Question: What type of chart is this?
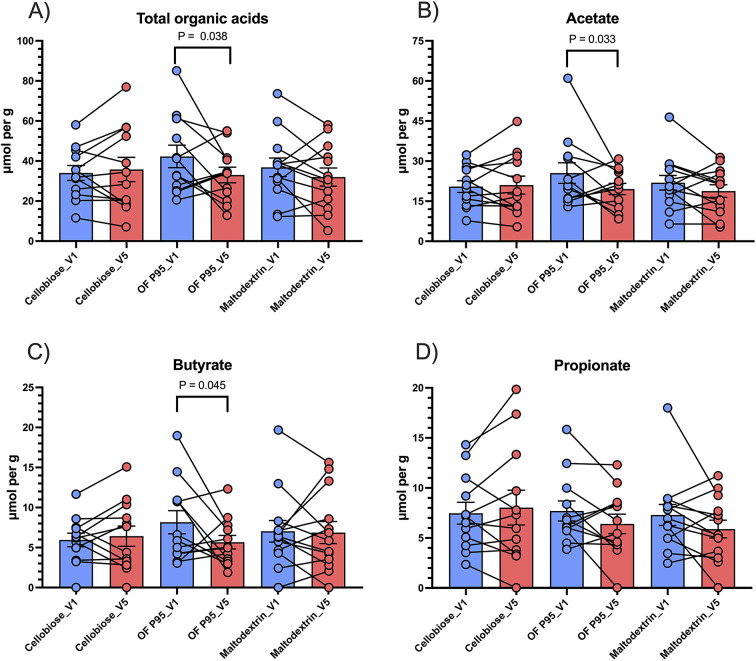
Answer: bar